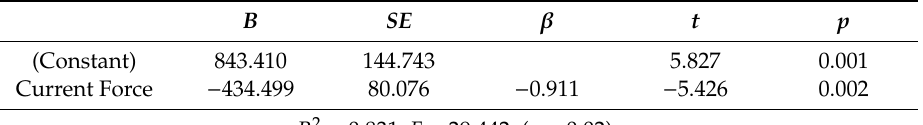
Table 2. Relationship between track deviation and current force in ebb